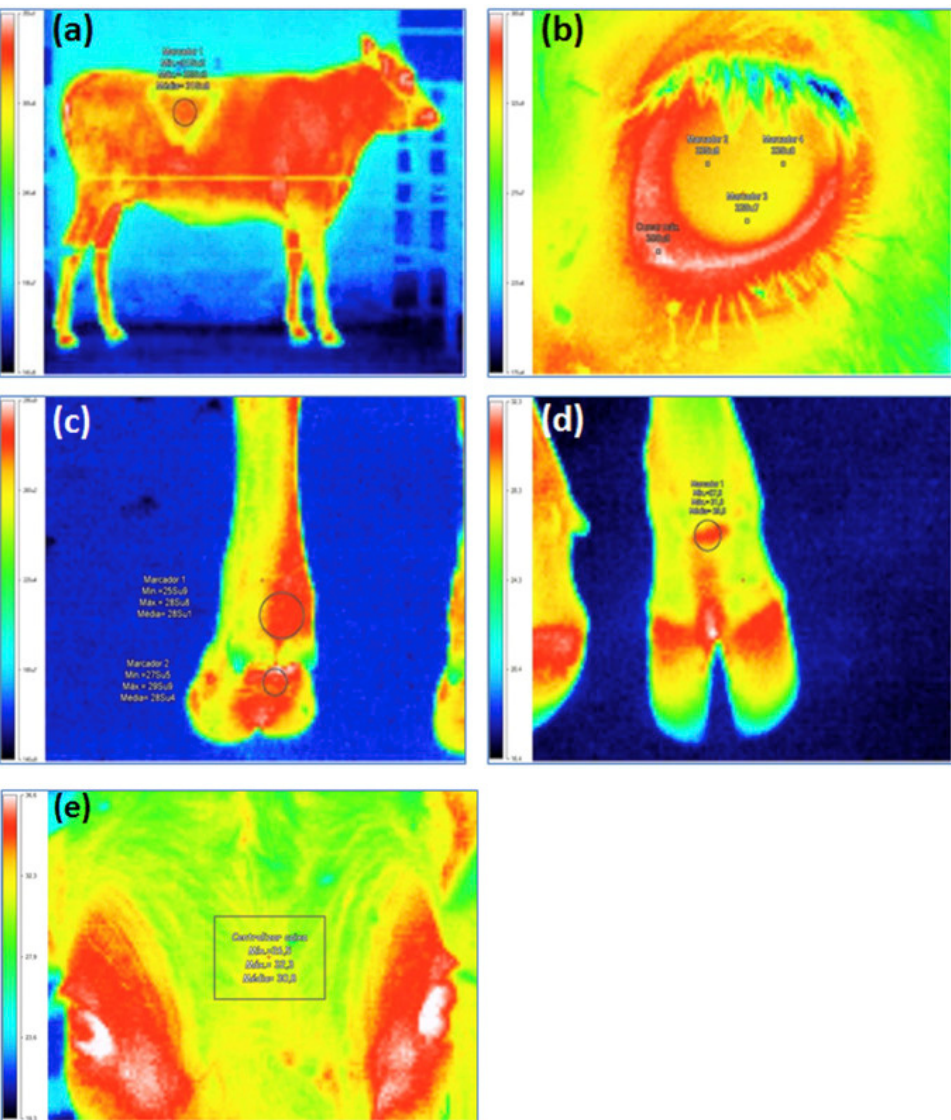
Figure 6. IRT imaging technology in animals welfare. Study regions of infrared thermography for ( a ) flank; ( b ) eye; ( c ) dorsal left foreleg; ( d ) cranial left foreleg; and ( e ) forehead of heifers. Reprinted with permission from Ref. [94]. Copyright Elsevier and copyright clearance